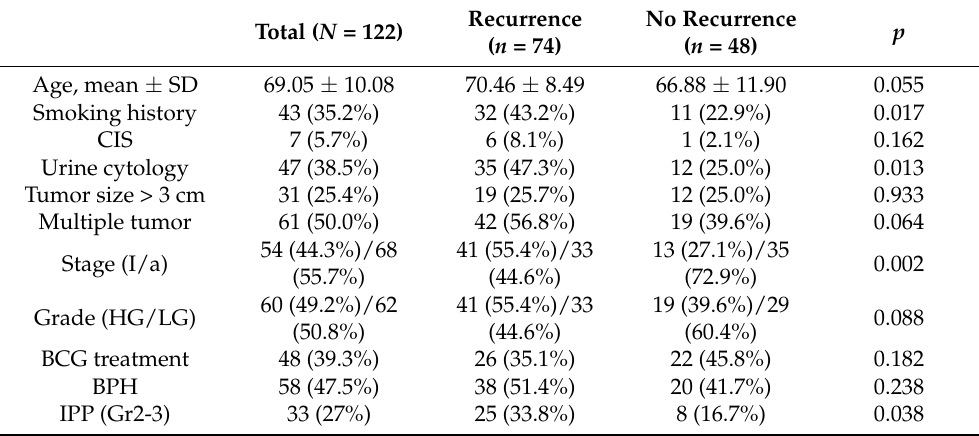
Table 1. Clinical and pathologic characteristics of patients with or without intravesical recurrence. Total ( N =